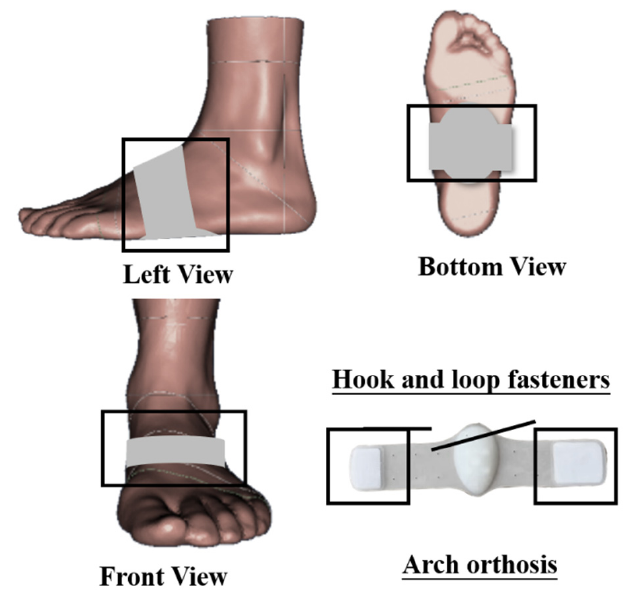
Figure 2. Illustration of arch support manipulation.